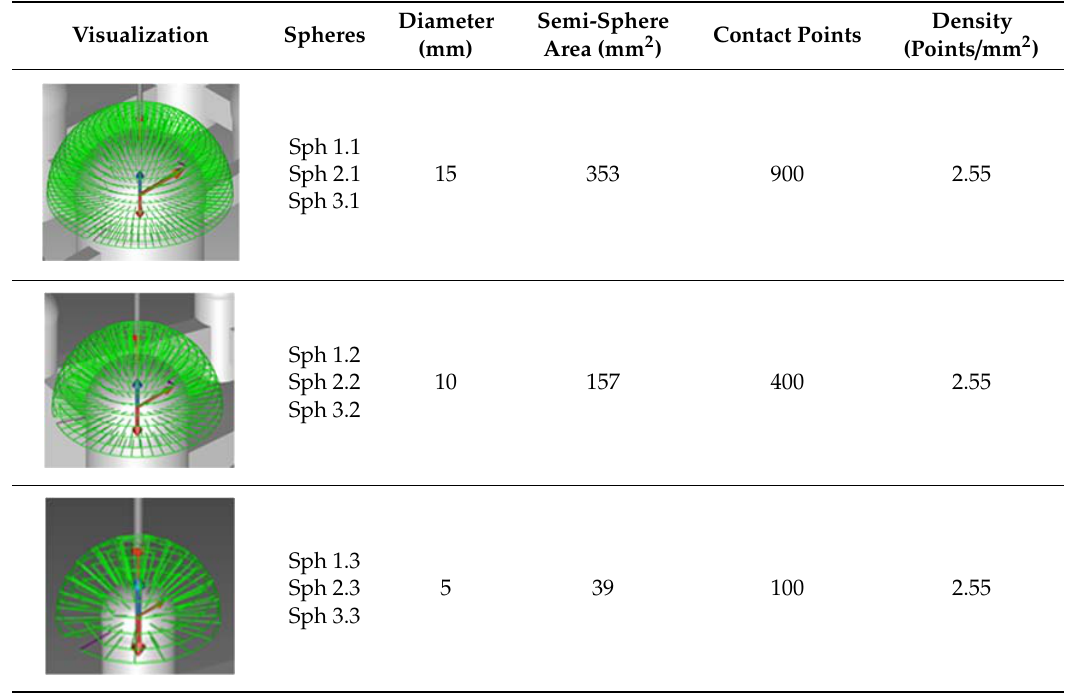
Figure 4. ( a ) Contact measurement of the test part; ( b ) alignment features of the test part. Table 1. Contact measurement parameters depending on the sphere diameter.